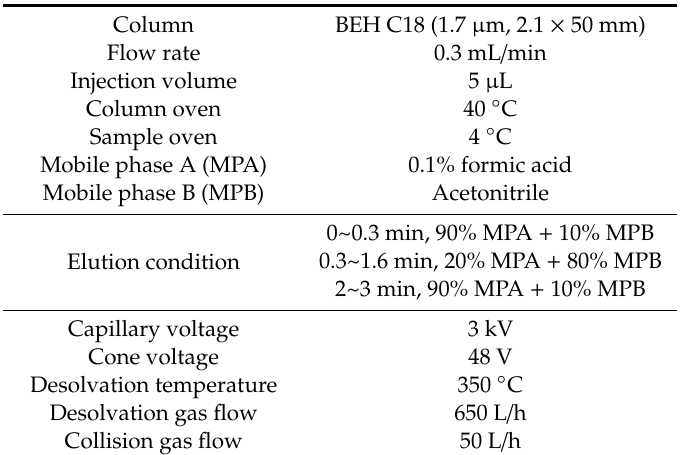
Table 1. Parameters of the UPLC–MS / MS system for analysis of nilotinib.